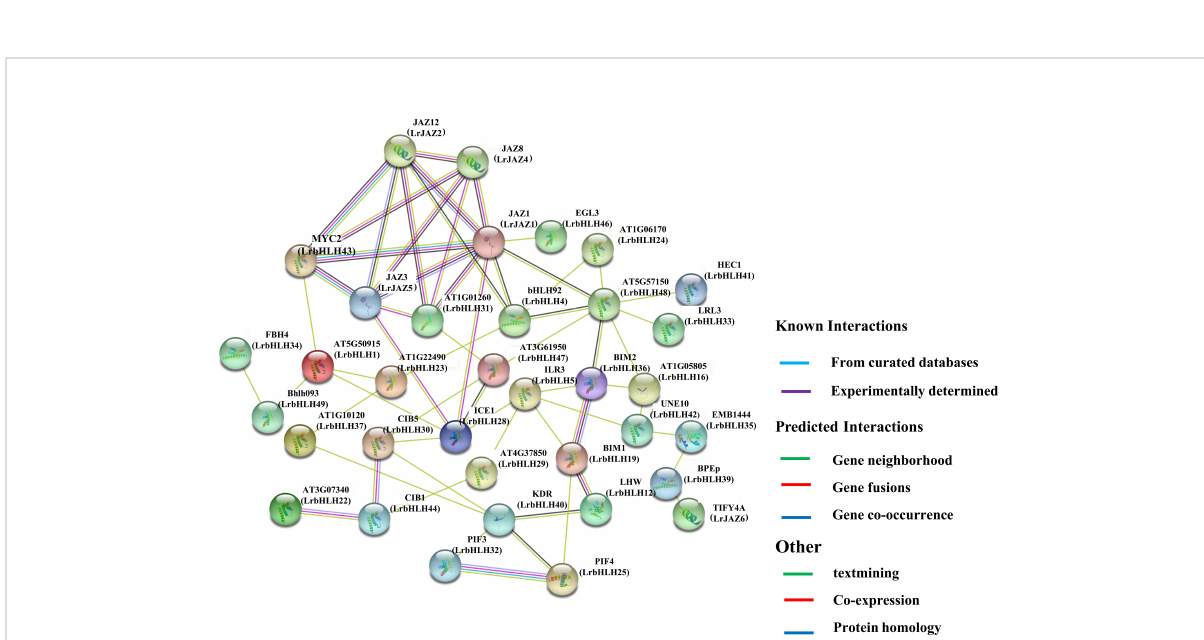
FIGURE 8 The predicted network of protein-protein interactions between LrbHLHs by STRING database. Different colors represent different interaction types. Arabidopsis bHLH names are marked, whereas their homologs in L. radiata are in parentheses.